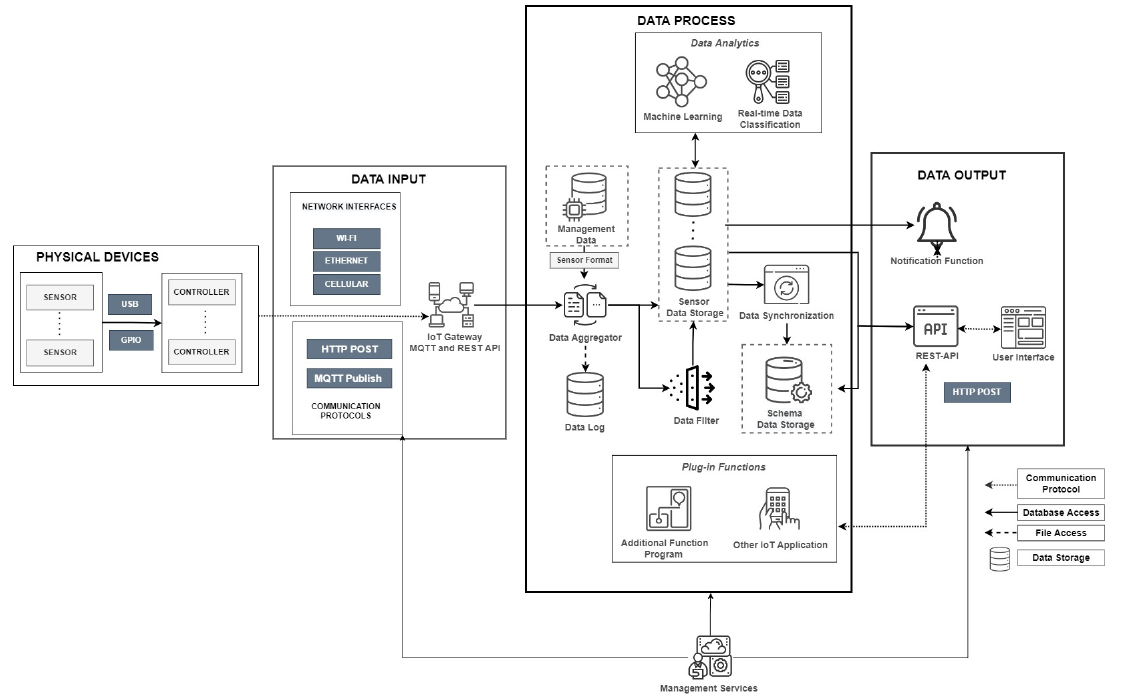
Figure 1. Design overview of SEMAR IoT server platform. Table 1. Nomenclature used in the